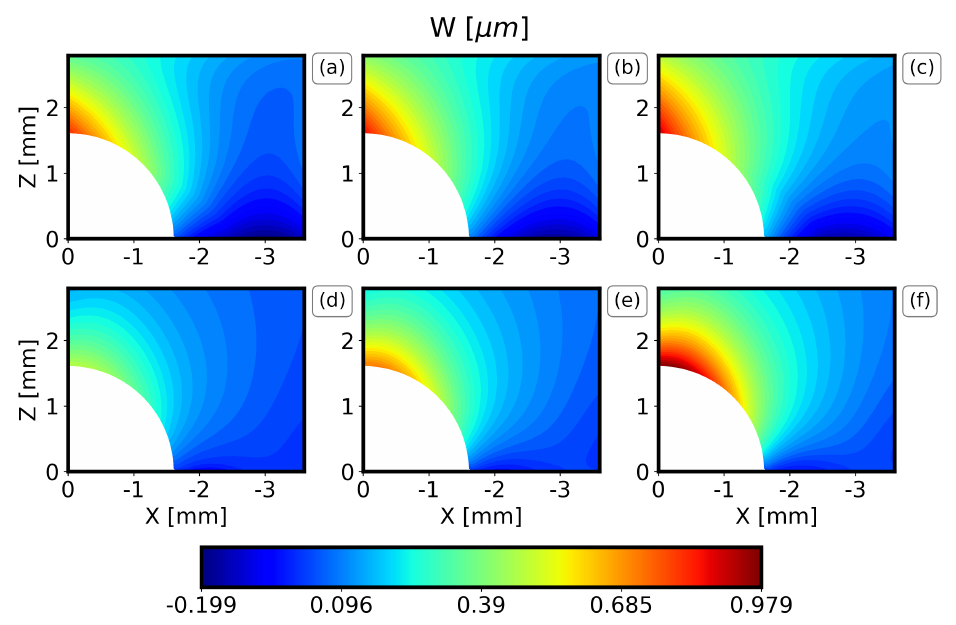
Figure 9. Comparison of DIC measurements and PC results for the W − displacement field and a drilling depth 2.0 mm. ( a ) Expected experimental value minus one standard deviation, ( b ) expected experimental value, ( c ) expected experimental value plus one standard deviation, ( d ) expected PC value minus one standard deviation, ( e ) expected PC value, ( f ) expected PC value plus one standard deviation.